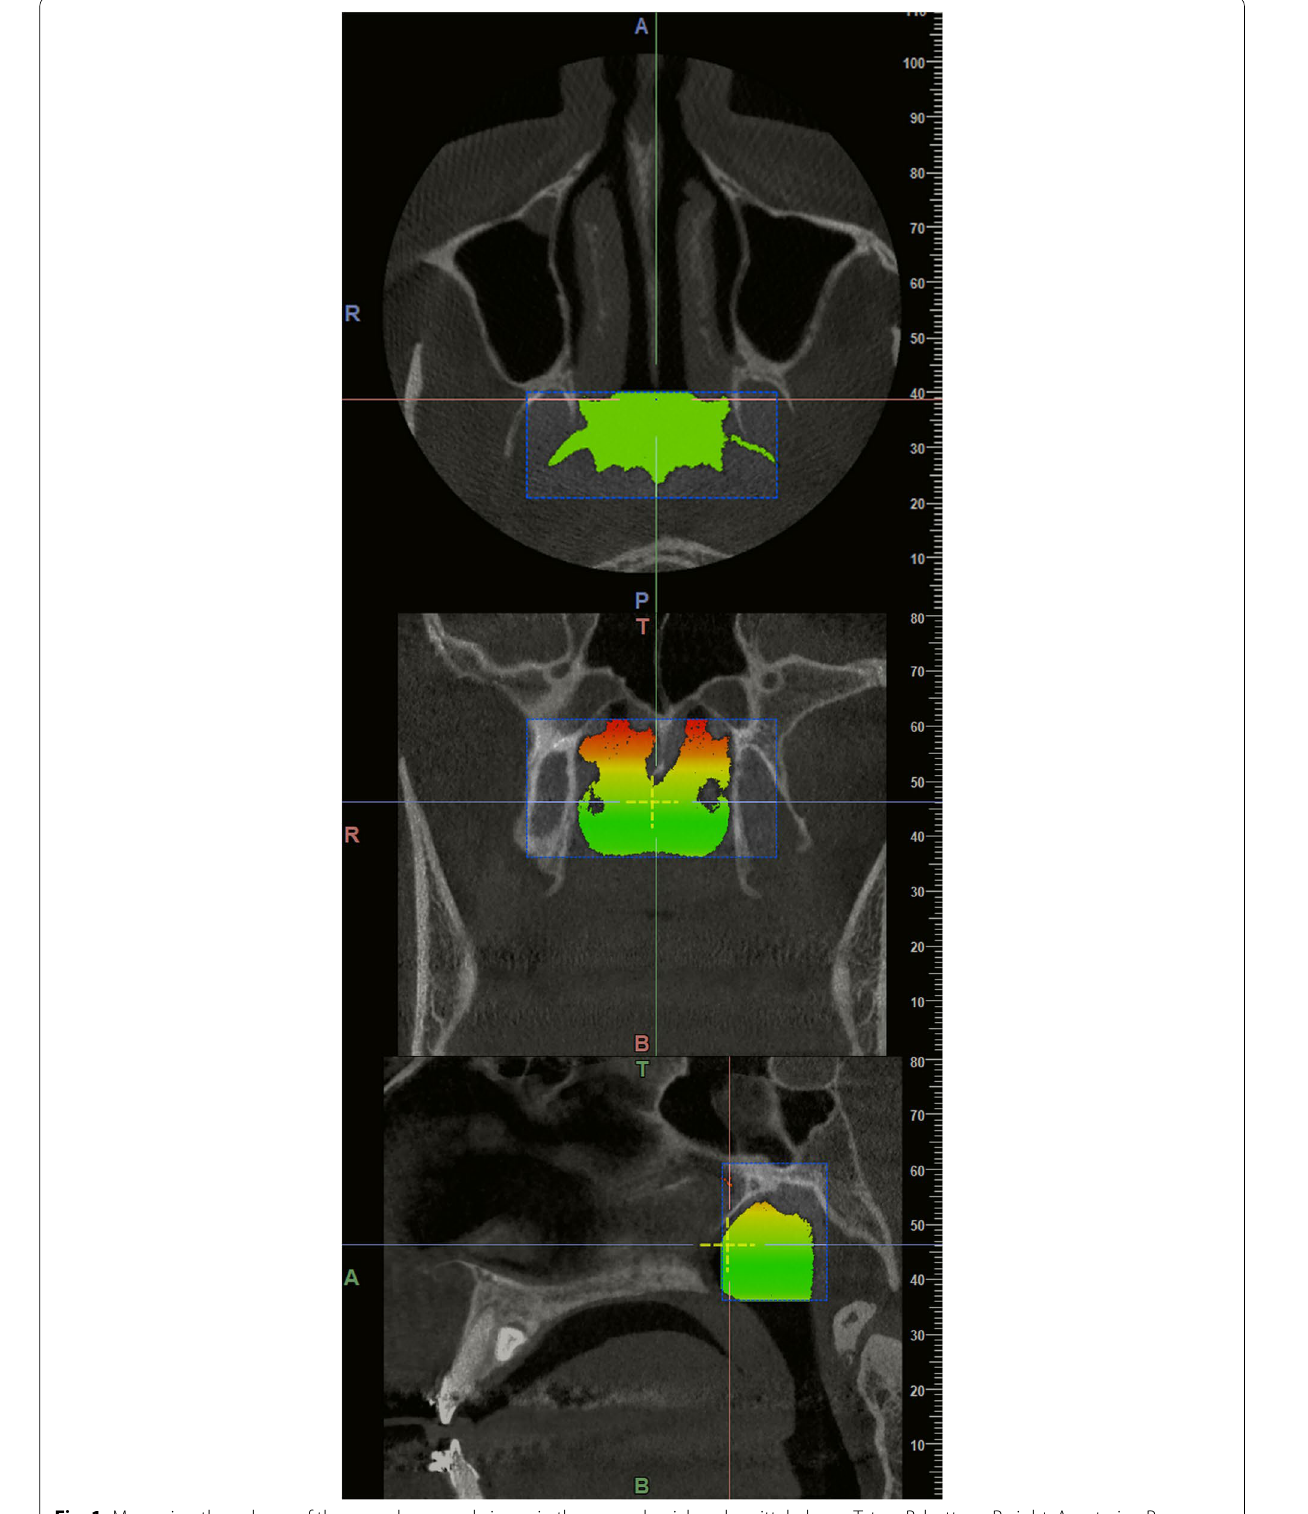
Fig. 1 Measuring the volume of the nasopharyngeal airway in the coronal, axial, and sagittal planes. T: top, B: bottom, R: right, A: anterior; P: